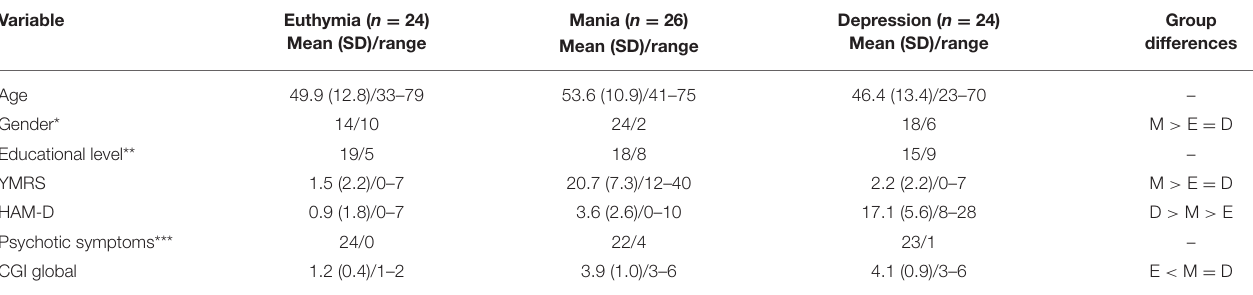
TABLE 1 | Socio-demographic and clinical characteristics of participants.